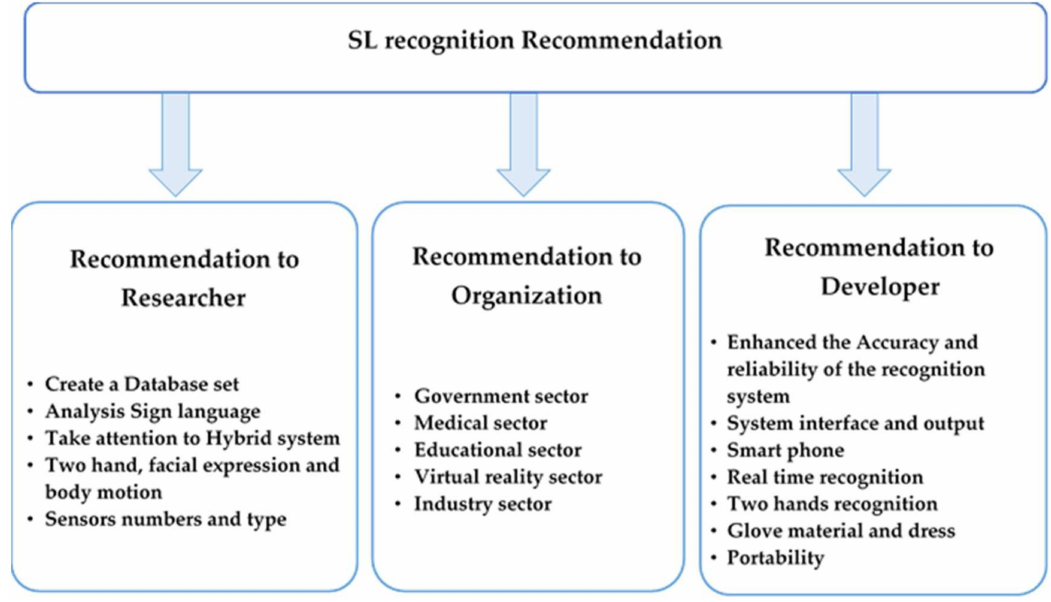
Figure 30. Categories of recommendations for SL recognition using